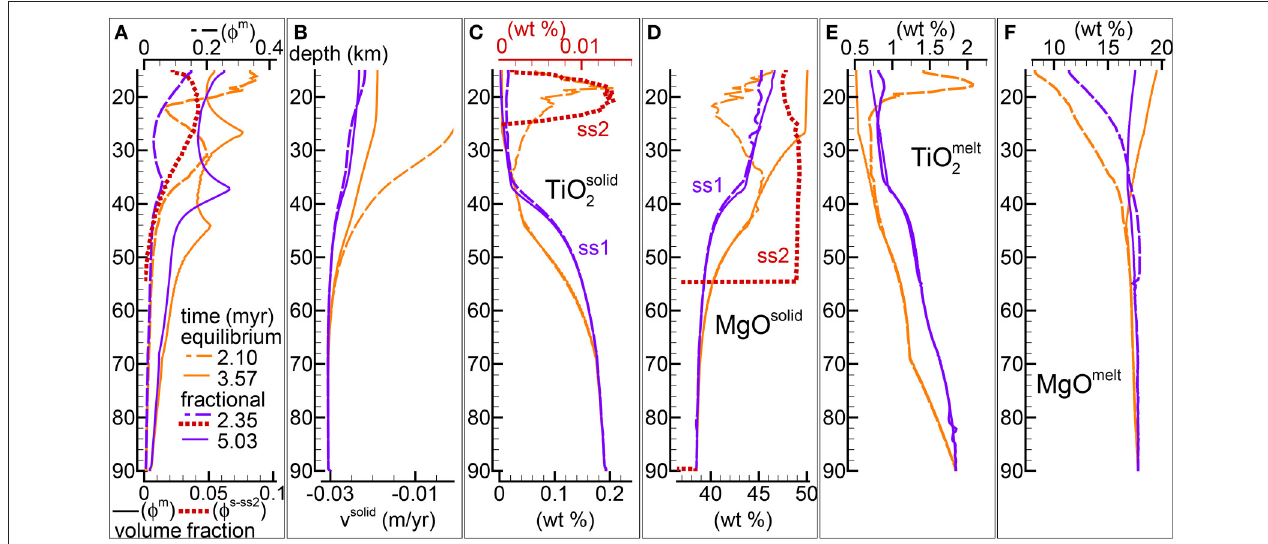
FIGURE 4 | Comparison between the DEM and DFM model with the alternative viscosity model. Solid viscosity model: µ s = µ s 0 (1 + 1 /φ m ) with µ s 0 = 1 e 20 Pa s, permeability constant C = 1e9 m − 2 . The equilibrium melting simulation is the same as in Figure 5 of MF1 (data file PHASE3-P2.YRC13.DAT , zip file max-front1-data2.zip ). To retrieve the data file for the DFM model PHASE3B-P2.YRC1.DAT included in the zip file max-front2-data.zip see the instructions provided in the Supplementary Material. (A) Melt volume fraction vs. depth at 2 different times (solid and dashed lines). Earliest time is marked by the first arrival of melt at the top for the equilibrium melting, and approximately the largest amount of melt reaching the top side for the DFM model. Red dotted line is the volume fraction of solid in sub-sys 2 at t ≈ 2.35 myr for the DFM model. (B) Velocity of the solid matrix. (C–F) Variation of solid and melt composition (wt %). (C) TiO 2 in the residual solid, also included the solid in sub-sys 2 for the DFM model (ss2, red dotted line). (D) MgO in the residual solid and solid in ss2 for the DFM model. (E) TiO 2 in melt. (F) MgO in melt.